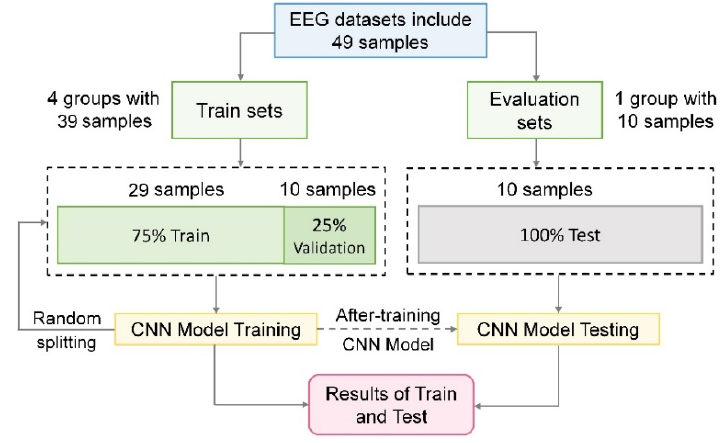
Figure 5. Illustration of the data used in the proposed model.